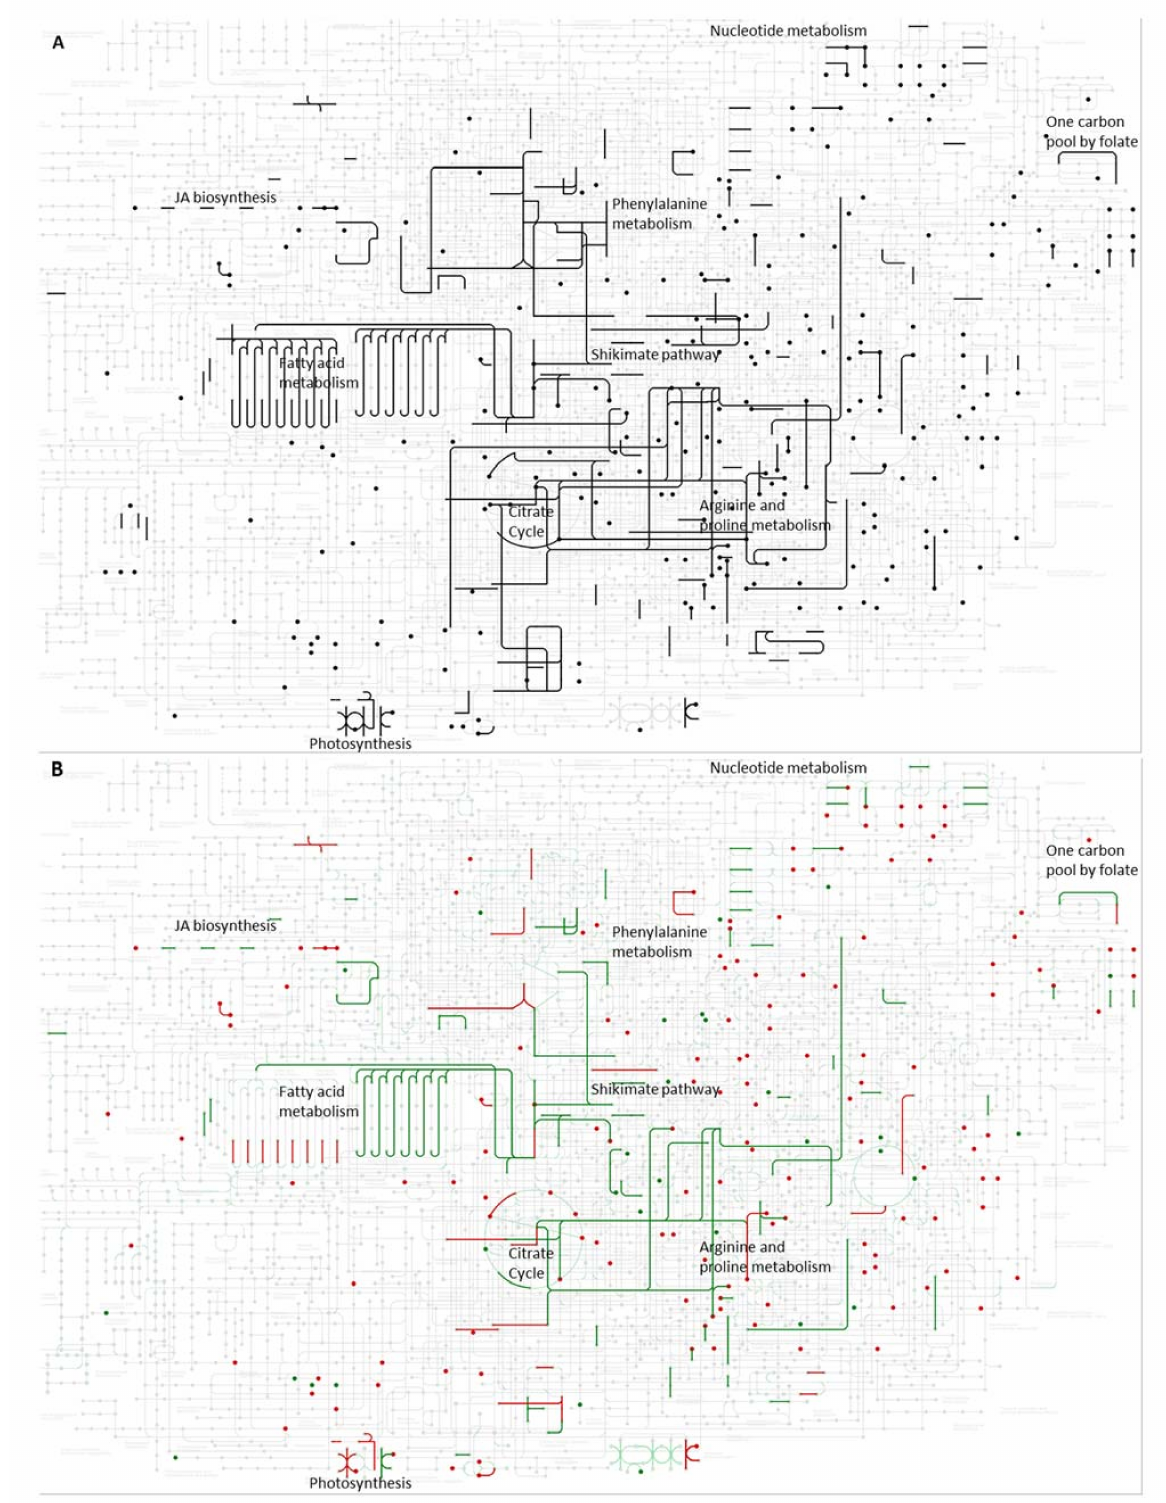
Figure 6. Integrated metabolite and protein network shown in KEGG pathways. ( A ) All metabolites and proteins found in samples are shown in KEGG pathway map. Dots indicate metabolites and lines indicate proteins. ( B ) Metabolites and proteins with significant changes (>twofold and p < 0.05) are shown in KEGG pathway map. Green indicates decreased in the mpk4 and red indicates increased in the mpk4 . Please refer to Figure S1 for a high-resolution version of the